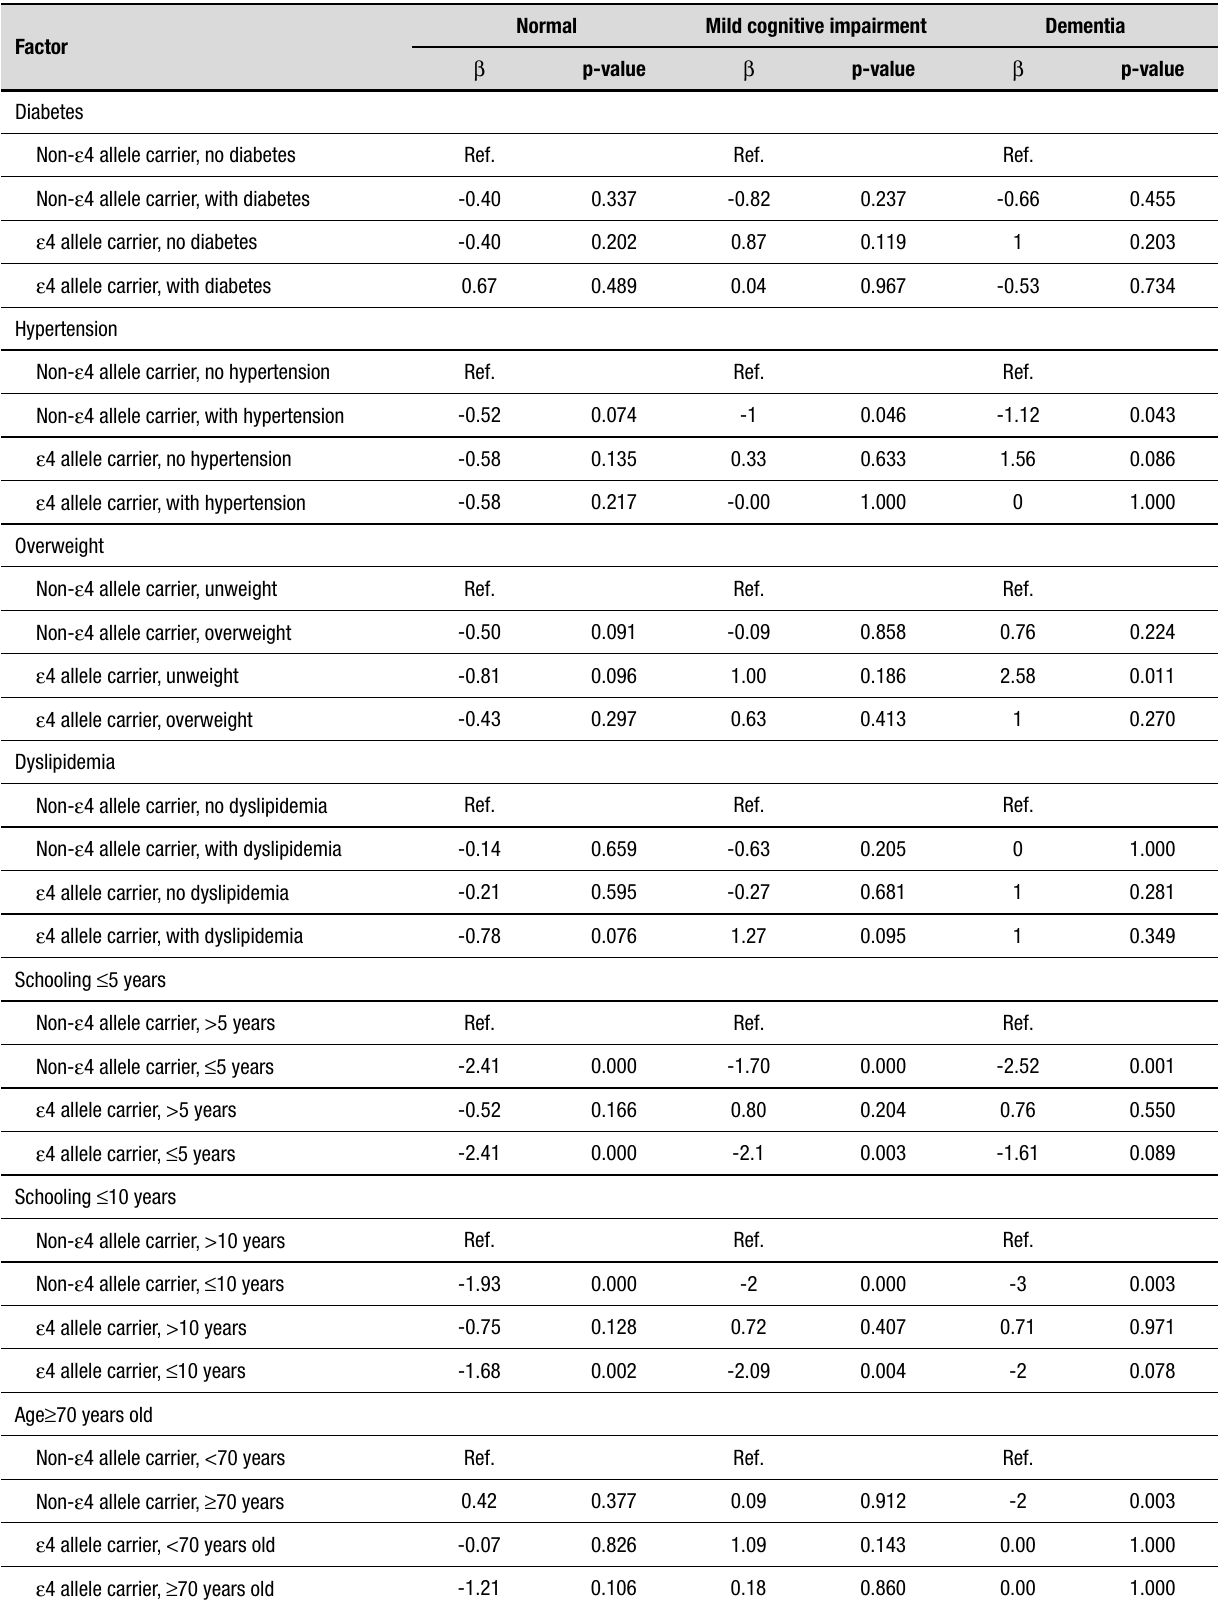
Table 5. Relationship between the Montréal Cognitive Assessment test and the age-adjusted interaction between risk factors and allelo ε 4. Normal Mild cognitive impairment Dementia Factor β p-value β p-value β p-value Diabetes Non- ε 4 allele carrier, no diabetes Ref. Ref.